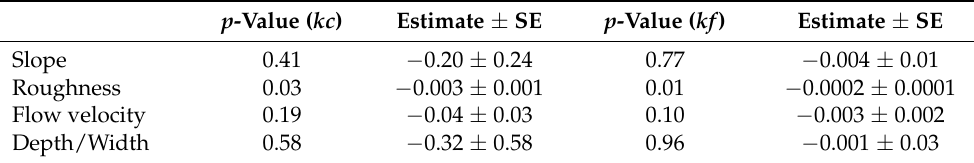
Table 5. Results of the GLM of predictor variables on kc and kf